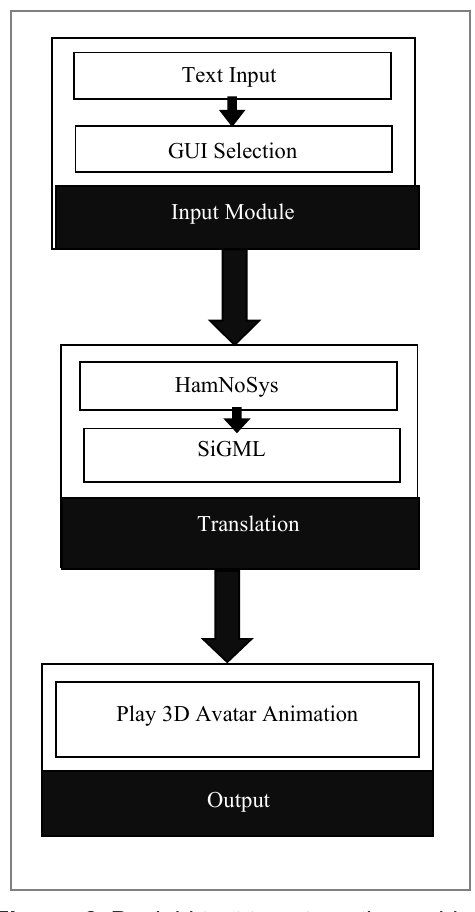
Figure. 2. Punjabi text to automatic machine translation system for ISL